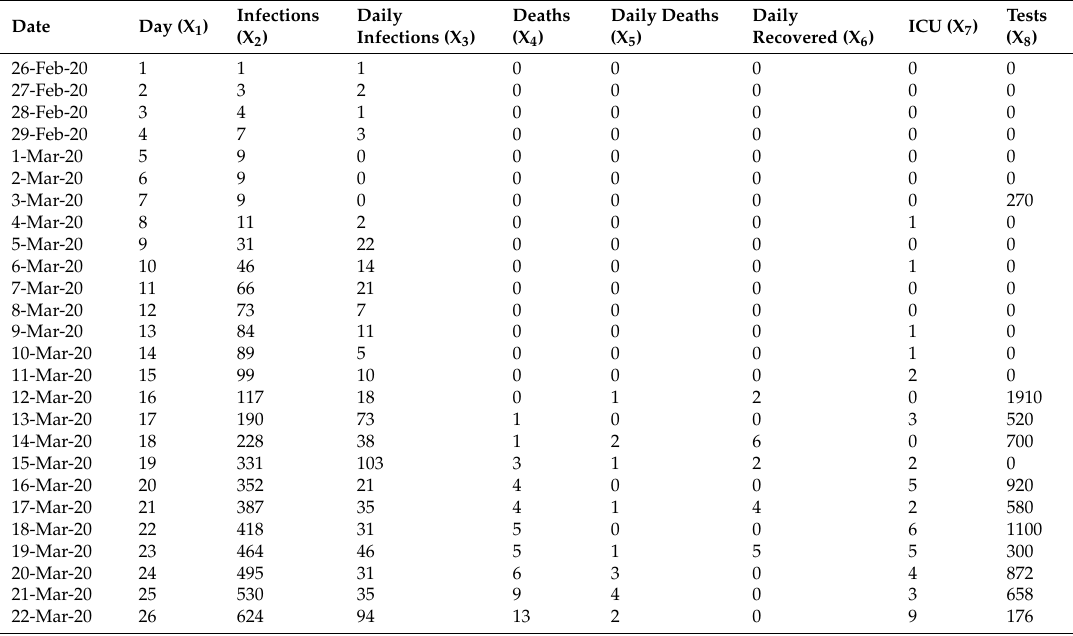
Table A1. The COVID-19 variables participating in the analysis